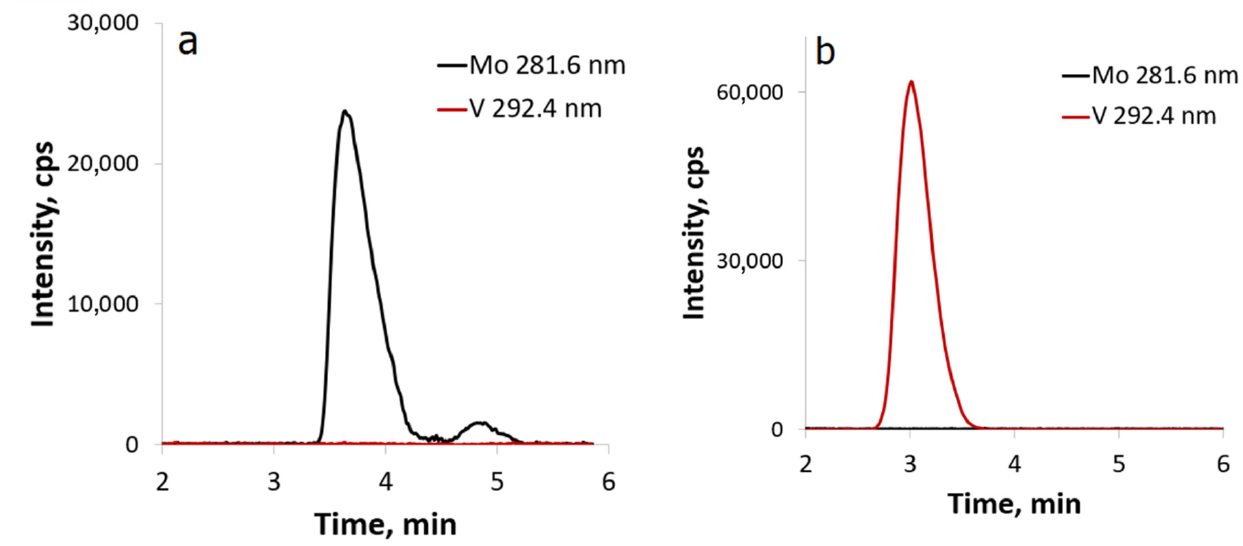
Figure 3. HPLC-ICP-AES chromatograms of ( a ) [ β -Mo 8 O 26 ] 4 − and ( b ) [V 10 O 28 ] 6 − in acetonitrile. Figure 3. HPLC ‐ ICP ‐ AES chromatograms of ( a ) [ β‐ Mo 8 O 26 ] 4 − and ( b ) [V 10 O 28 ] 6 − in acetonitrile. The reaction between (Bu 4 N) 4 [ β -Mo 8 O 26 ] and (Bu 4 N) 4 H 2 [V 10 O 28 ] in DMSO does not